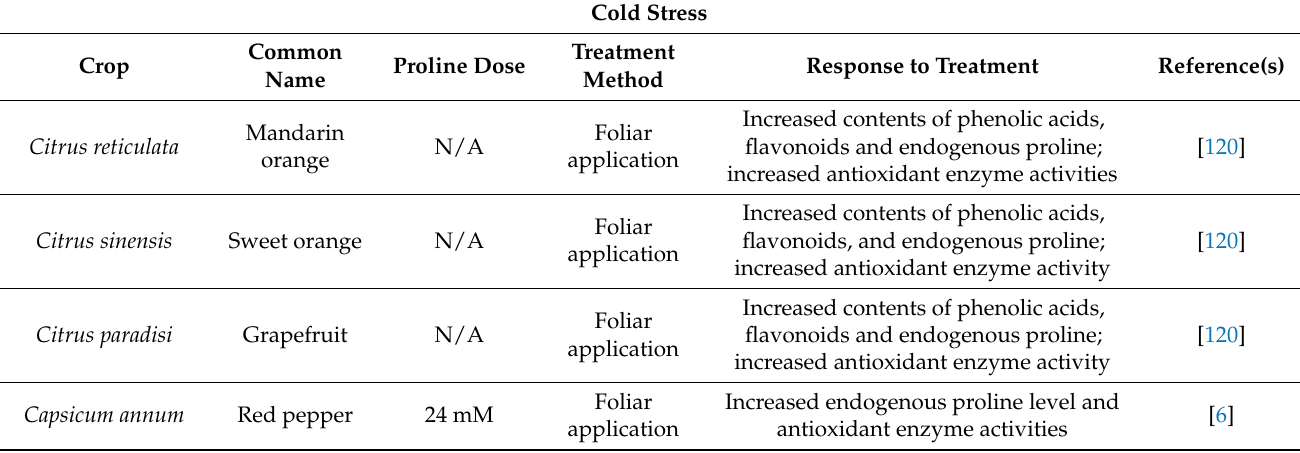
Table 14. Physiological responses of various crops to proline treatment against cold